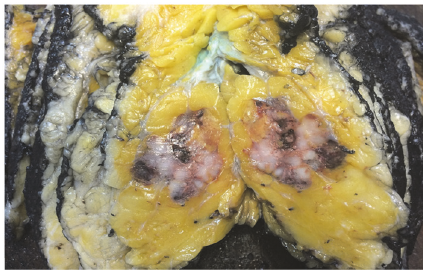
Figure 2: Macroscopic appearance of a well circumscribed, solid with subtle nodularity tumor, with central areas of necrosis.